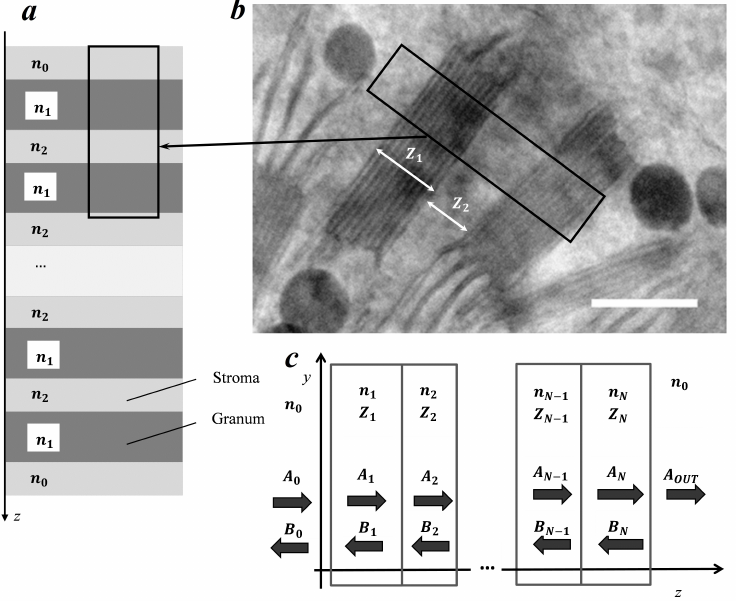
Figure 2. Simulation of a photonic-crystal layered structure with plane electromagnetic waves propagating along the z -axis. The black rectangle on the left corresponds to the right part of the image. Average granum thickness Z 1 = 120 nm. Average stromal distance between the grana Z 2 = 70 nm. Refractive indices: n 1 = 1.48 for granum; n 0 = n 2 = 1.33 for stroma. ( a ) Visual model representing the photonic crystal used in our calculations. ( b ) Part of the image taken from Figure 1b. ( c ) Distribution of electromagnetic wave amplitudes along a photonic crystal.